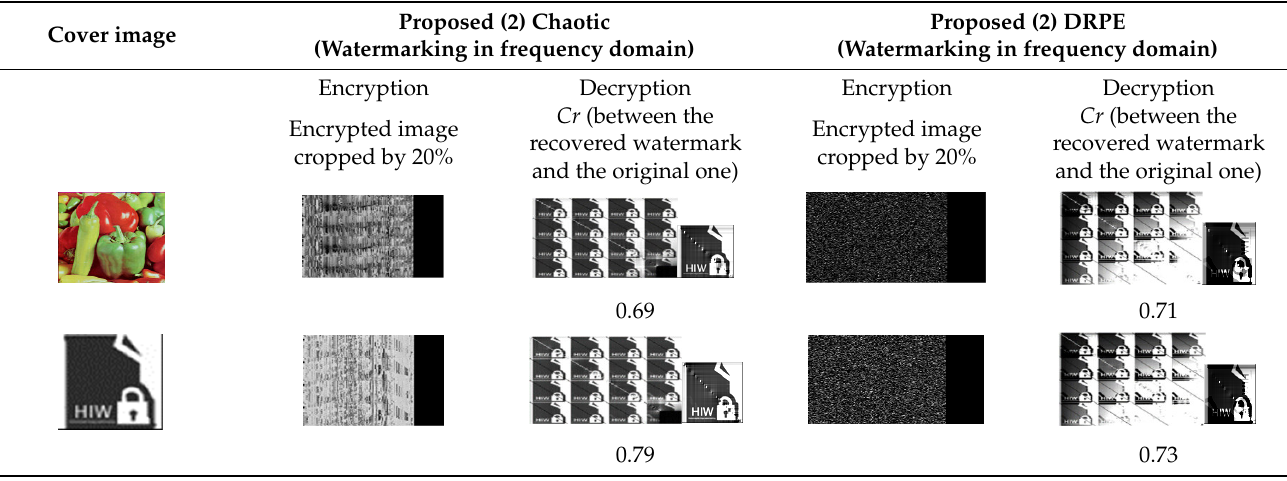
Table 12. Cropped images and corresponding extracted watermarks for the second proposed